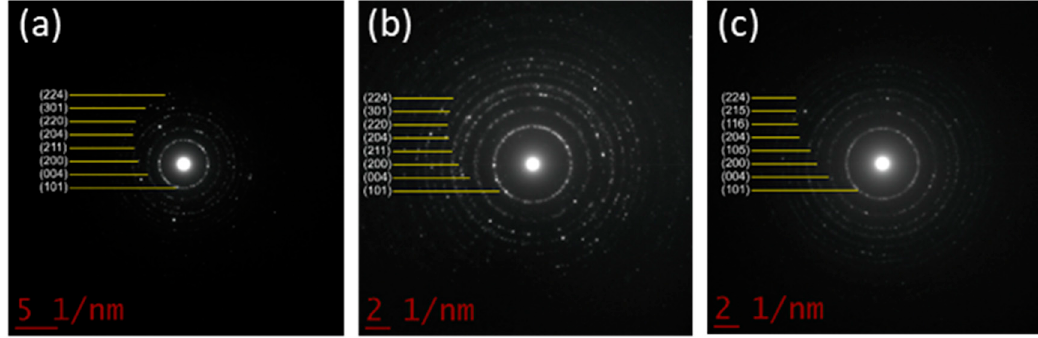
Figure 3. SAED pattern images of: ( a ) TiO 2 ; ( b ) Co/TiO 2 ; ( c ) Cu/TiO 2 ; ( d ) Fe/TiO 2 ; and ( e ) Ni/TiO 2 . 3.3. UV-VIS by Diffuse Reflectance Spectroscopy Figure 4 shows the UV-Vis diffuse reflectance spectra of the TiO 2 and deposited-TiO 2 photocatalysts. TiO 2 exhibited a strong absorption band between 400 and 450 nm (Figure 4a), which is characteristic of O 2p → Ti 3d transitions in the tetrahedral structure or TiO 2 in its anatase phase [36]. The TiO 2 NPs present two shoulders around 200–250 and 250–300 nm (bands associated with bulk crystals), which may change with the incorporation of doping ions, promoting a displacement in the UV-light absorption spectra [37]. Pure TiO 2 exhibits an absorption band edge at 421 nm (ultraviolet absorption) [38], and similar trends were observed in Co/TiO 2 (416 nm), Cu/TiO 2 (451 nm), Fe/TiO 2 (443 nm), and Ni/TiO 2 (408 nm) samples. The band-gap (Eg) energies of the nanomaterials were calcu- lated by applying the Tauc’s plot method and Kubelka–Munk function [27]; results are shown in Table 1. The nanoparticles of Co/TiO 2 (2.80 eV), Ni/TiO 2 (2.85 eV), and TiO 2 (2.77 eV) showed similar results, unlike Cu/TiO 2 (2.50 eV) and Fe/TiO 2 (2.53 eV), which exhib- ited a significant reduction in Eg values. It is well known that, when Eg exhibits a redshift displacement, we can observe an increment in the optical absorption of the nanoparticles promoting the absorption in the UV-visible region [39,40]. In this context, a displacement of Eg value in nanomaterials helps to increase their photocatalytic efficiency in the degra- dation of organic contaminants [41,42].